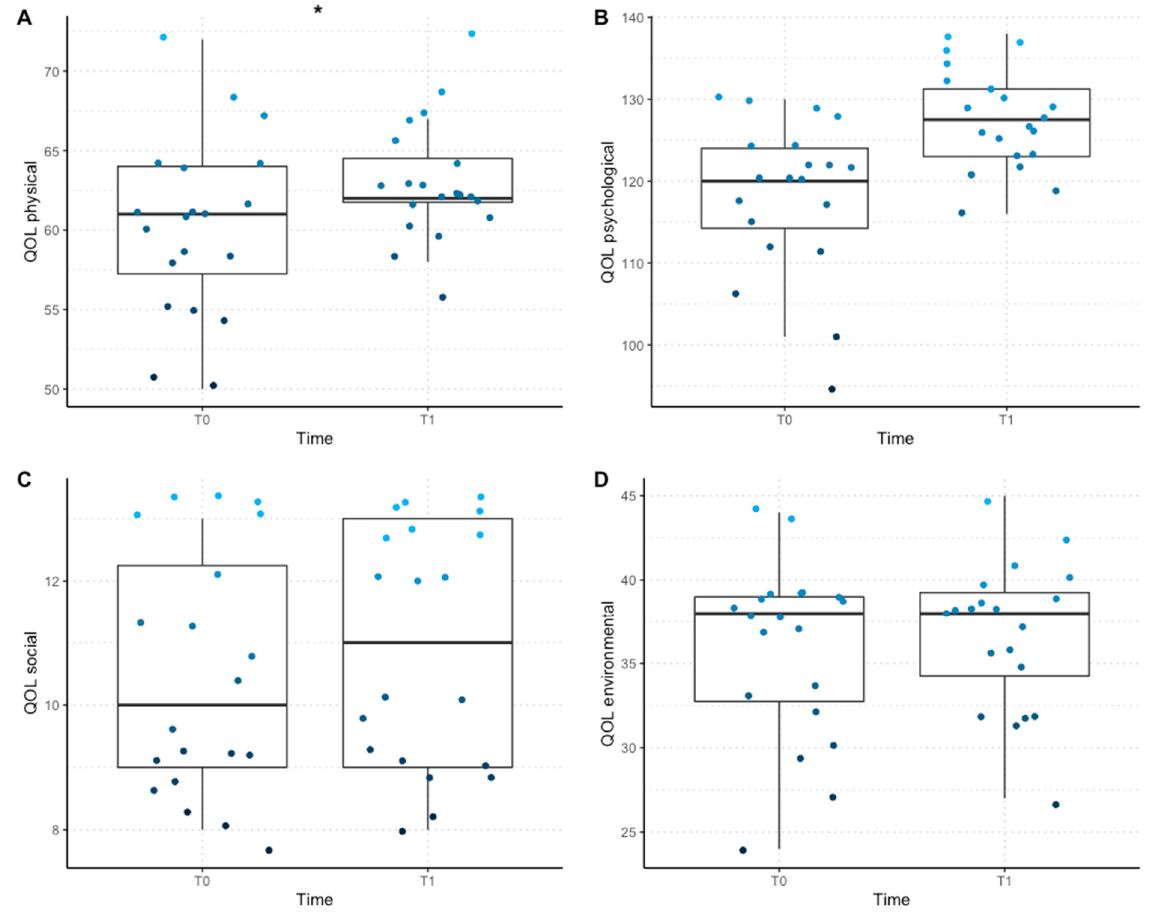
Figure 1. Distribution of the QOL score for each domain, divided by responding time (T 0 vs. T 1 ). The middle line in the box plots represents the median score, the extremes of the boxes represent the lower and upper quartiles, and the error bars represent the minimum and the maximum scores; * = p < 0.001. ( A ) Scores for the physical domain of QOL; ( B ) scores for the psychological domain of QOL; ( C ) scores for the social domain of QOL; ( D ) scores for the environmental domain of QOL.